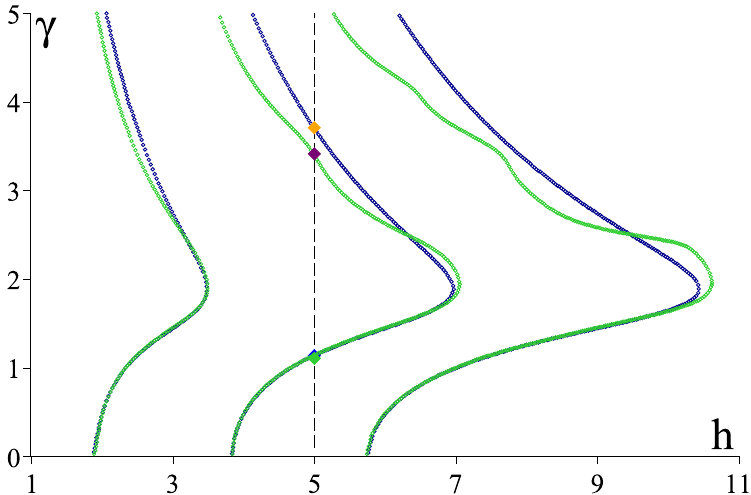
β α (green curve) P 1.141 (blue), ≈ 1.112 (green), (cid:98) γ 2,2 3.404 ≈ ≈